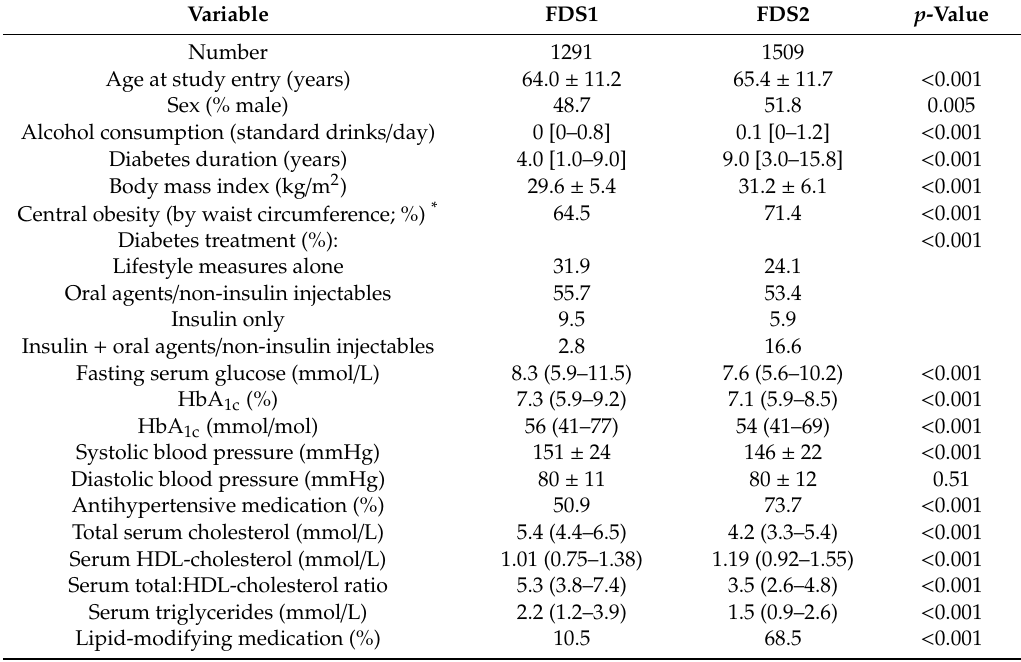
Table 2. Baseline characteristics of participants with type 2 diabetes in the Fremantle Diabetes Study Phase I (FDS1) and FDS Phase II